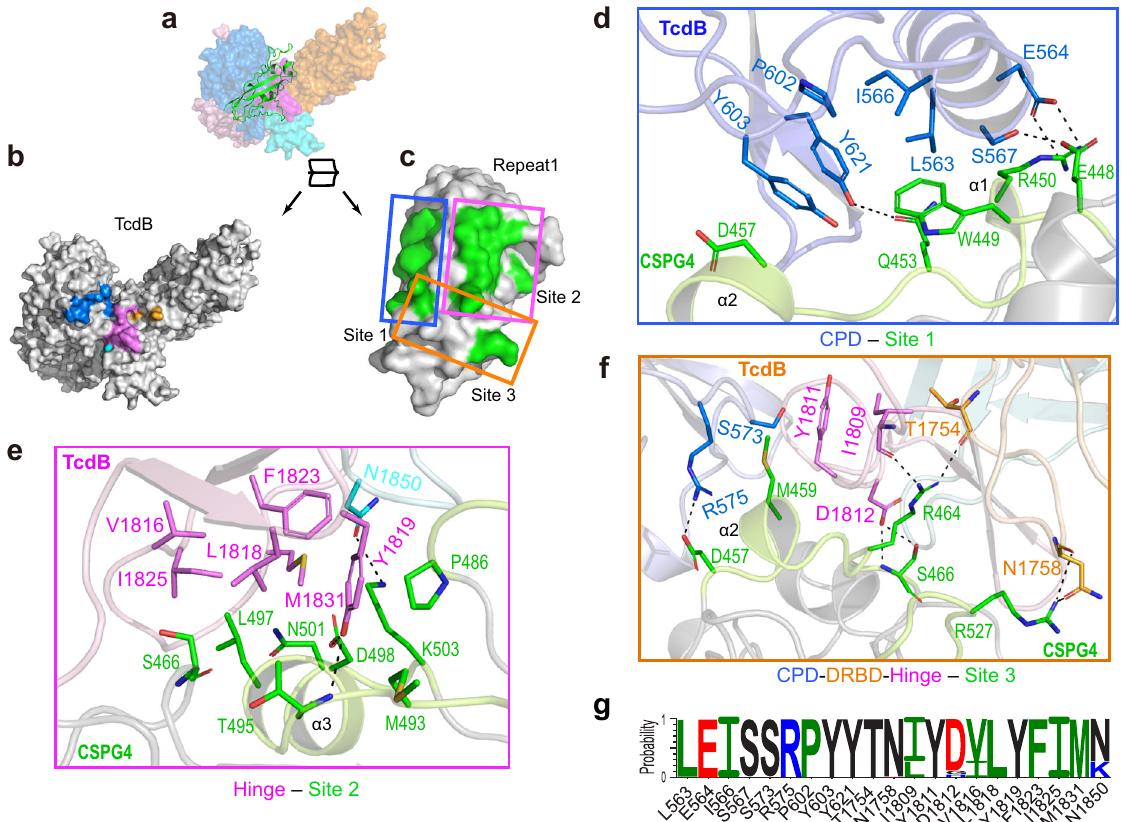
Fig. 2 TcdB recognizes CSPG4 using a composite binding site involving multiple domains. a CSPG4 Repeat1 binds at a groove formed by the CPD, DRBD, hinge, and CROPs I. TcdB core and Repeat1 are shown as a surface and a cartoon representation, respectively. b , c An open-book view of the TcdB core – Repeat1 interface. CSPG4-binding residues in the CPD, DRBD, hinge, and CROPs are colored blue, orange, purple, and cyan, respectively ( b ). The amino acids in Repeat1 that constitute the three TcdB-binding subsites are colored green and outlined in blue, purple, and orange boxes ( c ), while their detailed interactions with TcdB are further illustrated in d – f . d – f Close-up views of the TcdB – CSPG4 interface with interacting amino acids shown in stick models. Residues in the CPD, DRBD, hinge, and CROPs I of TcdB are colored blue, orange, purple, and cyan, respectively, while Repeat1 resides are colored green. g Graphical representations of sequence conservation of CSPG4-binding residues in TcdB. The height of symbols at each position indicates the relative frequency of each amino acid at that position based on analyses of 206 unique TcdB